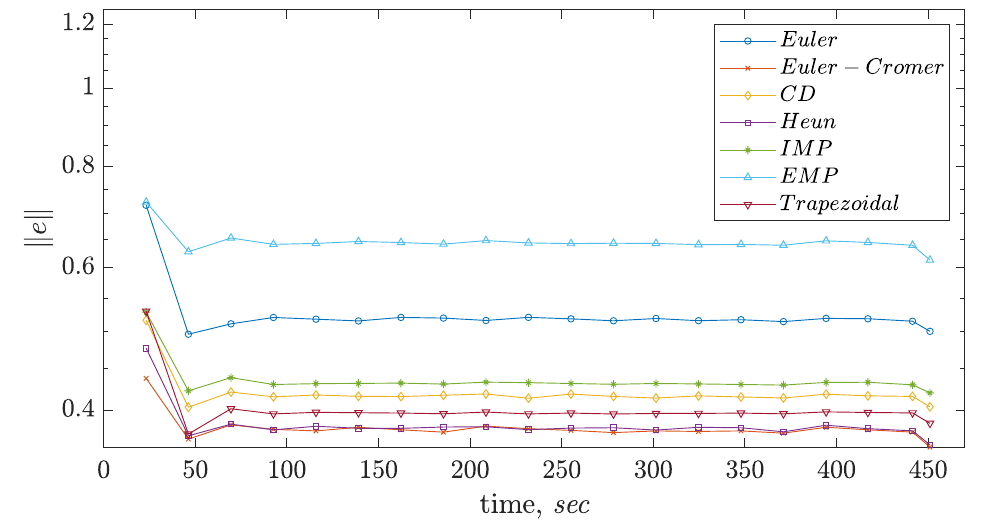
Figure 9. Synchronization error between master and slave systems for different integration methods, smoothed with a median filter; the window size is 200